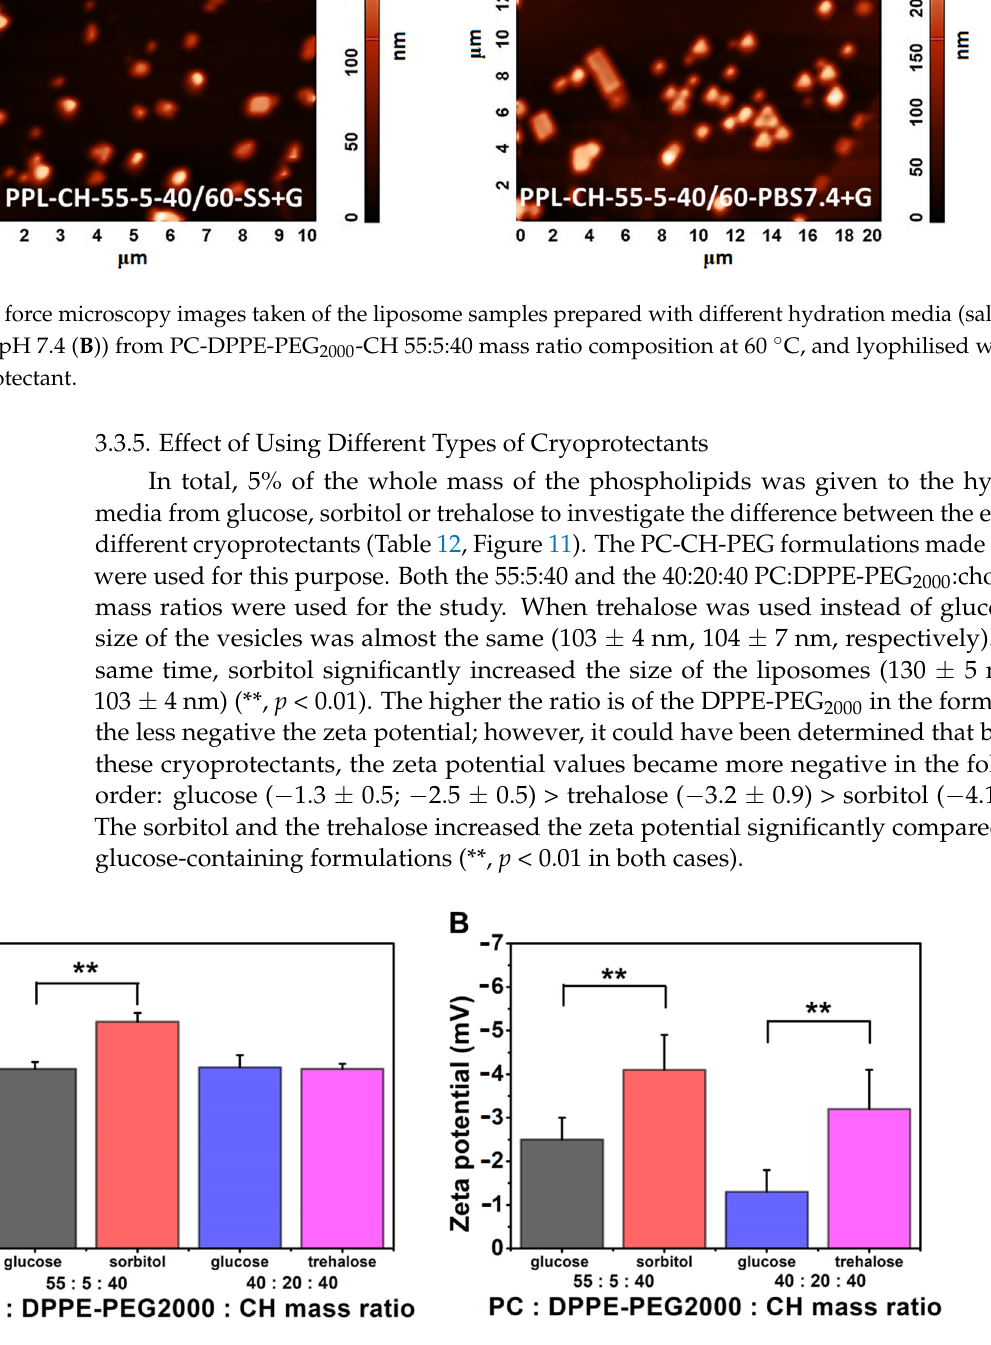
Figure 11. Characteristic features of the liposome samples lyophilised with different cryoprotectants prepared from PC- DPPE-PEG 2000 -CH 55:5:40 or 40:20:40 mass ratio composition at 60 °C and hydrated with saline solution, presenting the results of the investigations: vesicle size and zeta potential analysis ( A , B ). **: p < 0.01